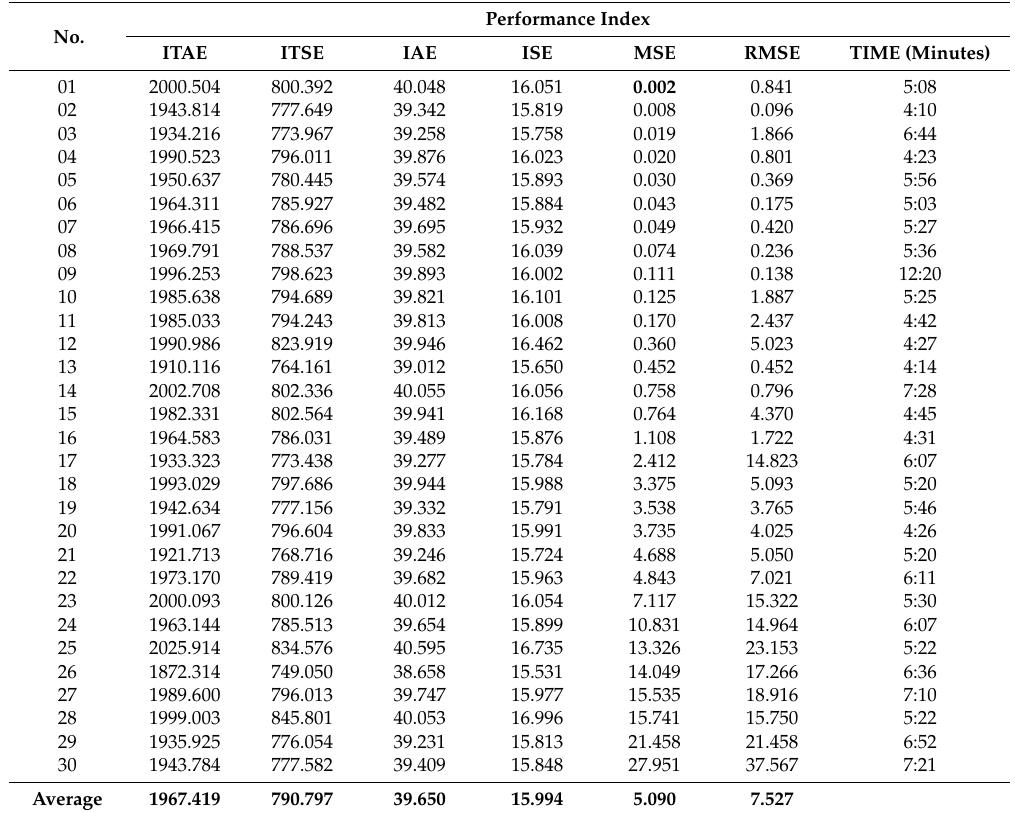
Table 5. Simulation errors with the traditional BCO algorithm without a level of noise.